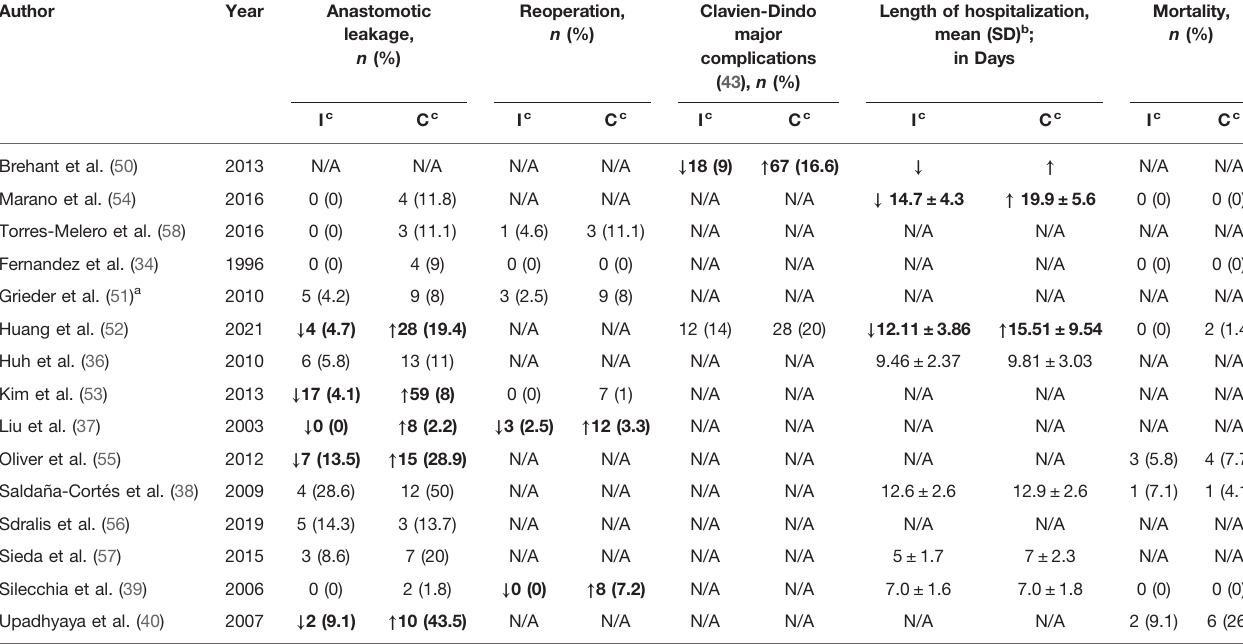
TABLE 3 | Postoperative